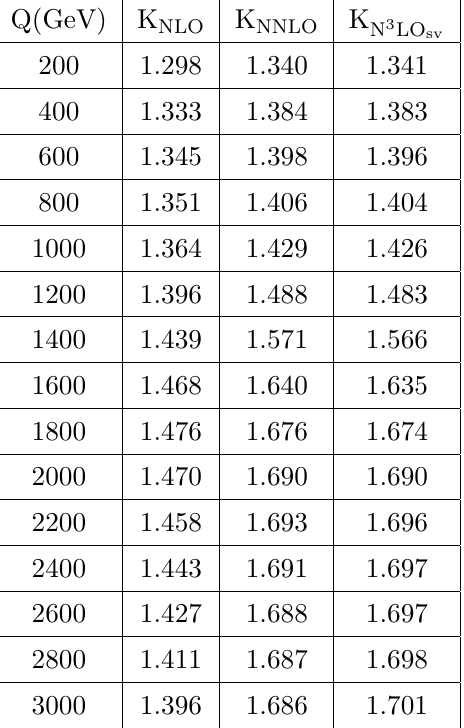
Table 2 . The (cid:12)xed order K-factors for the signal (SM+GR) of di-lepton invariant mass distribution at the LHC up to N 3 LO sv for select invariant mass